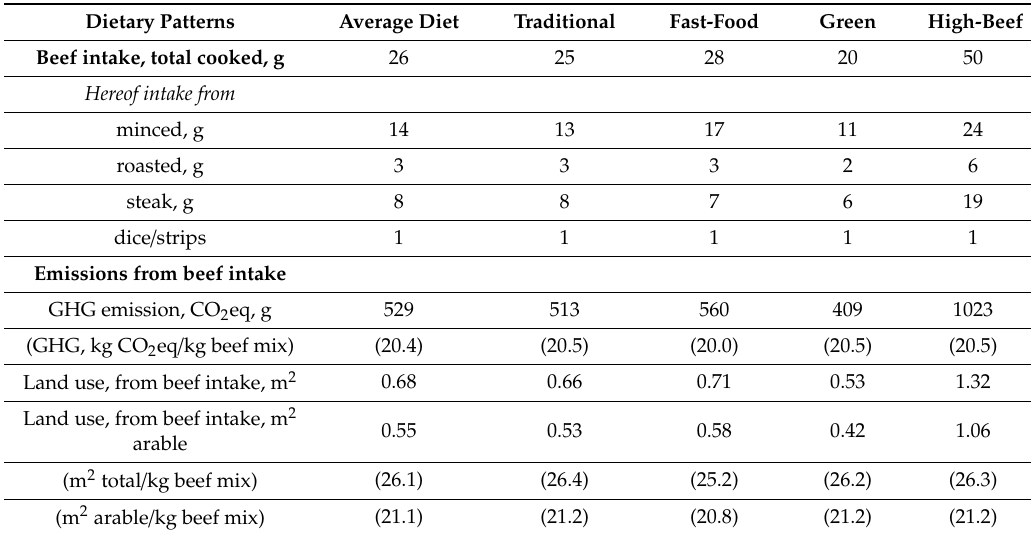
Table 3. Consumption of di ff erent beef products in the Average diet and in di ff erent dietary patterns and the related greenhouse gas (GHG) emission and land use from beef scaled to a total daily intake of 10 MJ per adult person, per person per day including the whole